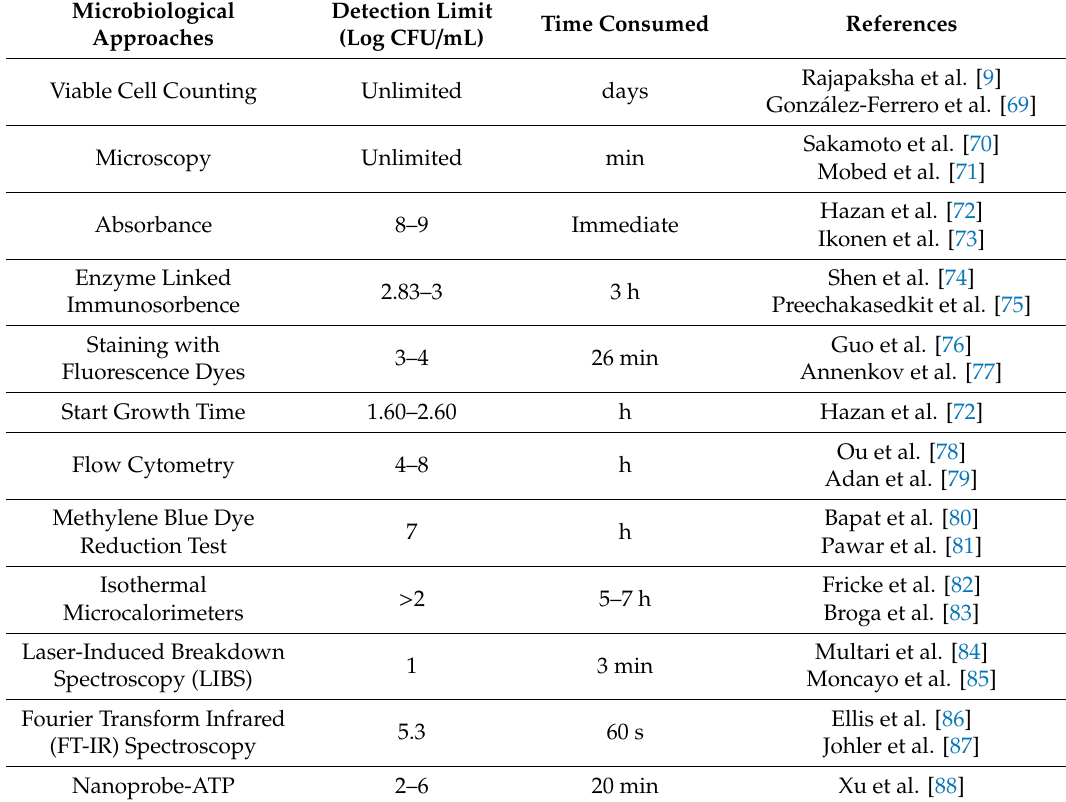
Table 2. Examples of Microbiological Analysis Approaches for Monitoring Food